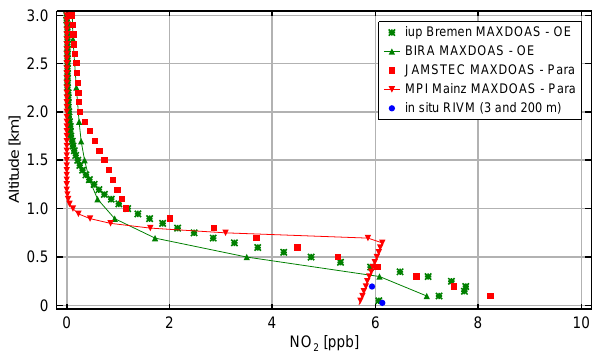
Fig. 16. NO 2 surface concentrations for in-situ (IUP Bremen, red), lidar (RIVM, blue), and MAX-DOAS (IUP Bremen,